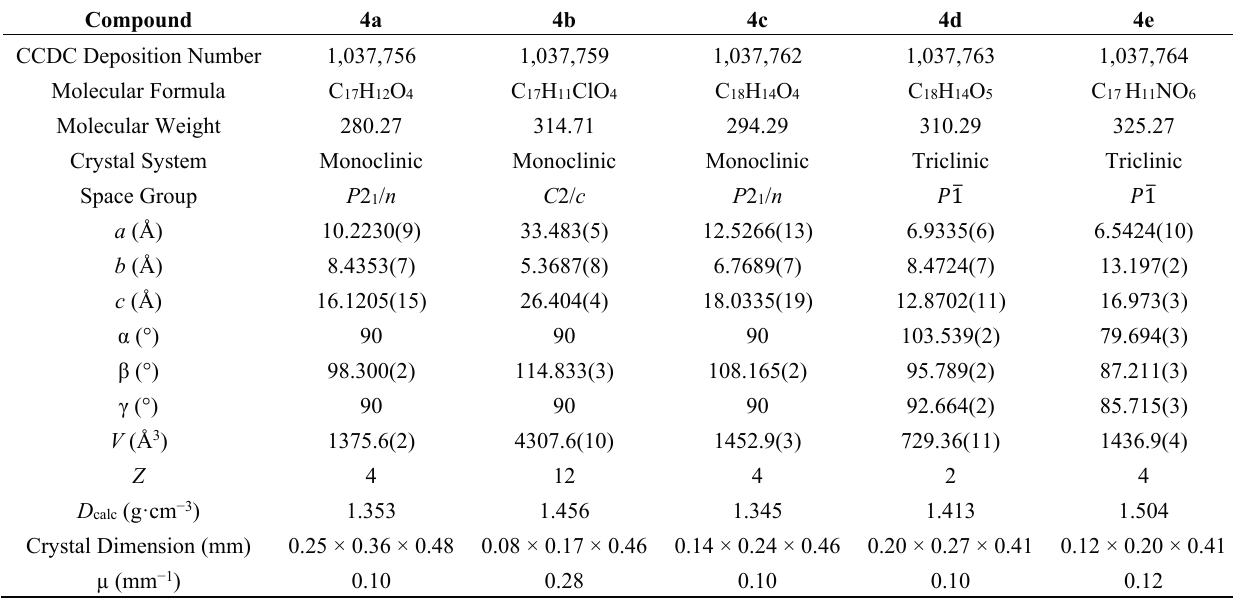
Table 1. Crystal data and refinement parameters for 4 ( a – e